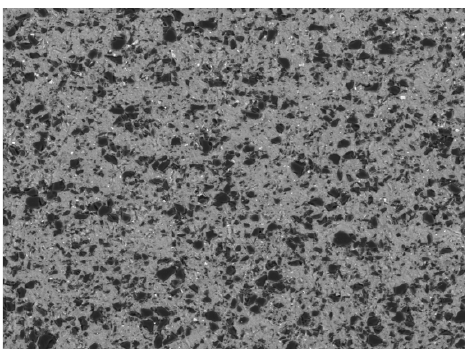
Figure 2. Initial microstructures of B 4 C p /6063Al composite.